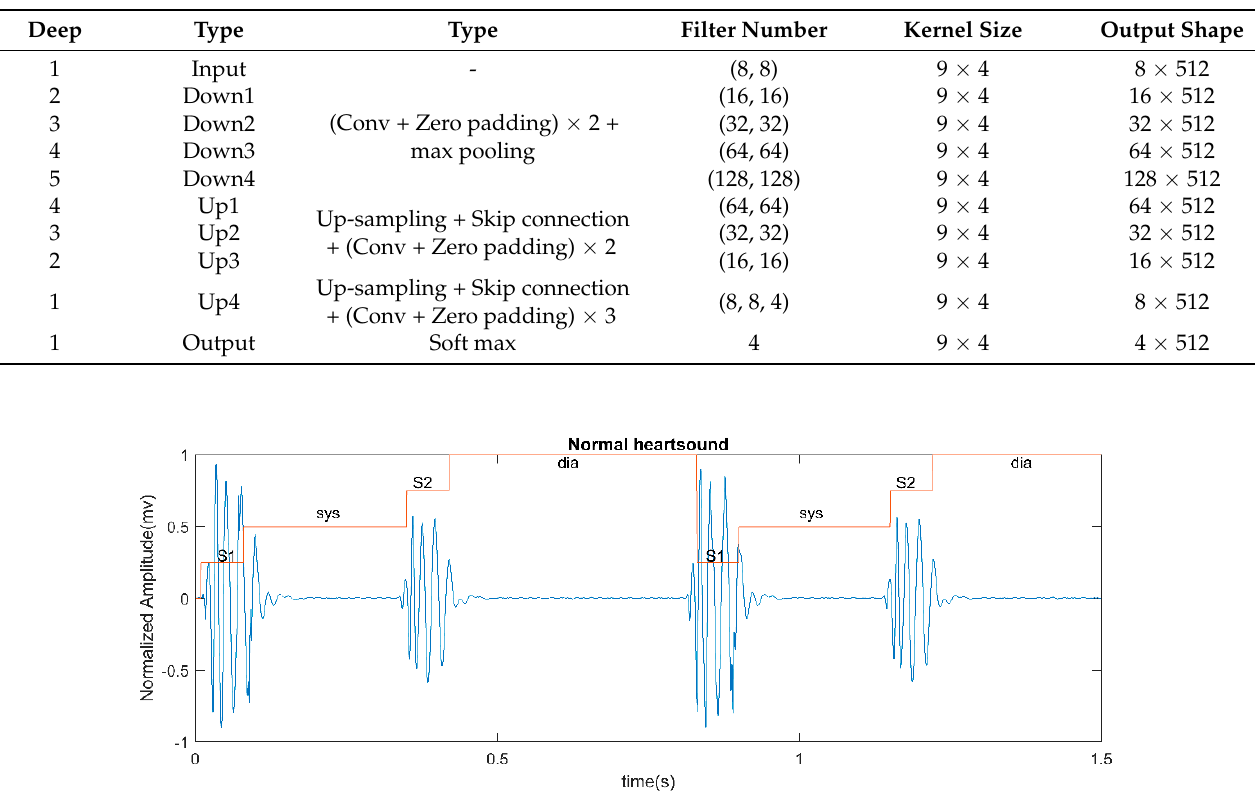
Figure 11. The segmentation results of an example of a normal heart sound includes two heart sound cycles, and each cycle consists of the following heart sound components: S1, sys, S2, and dia. Table 6. Parameters setting of the segmentation model.